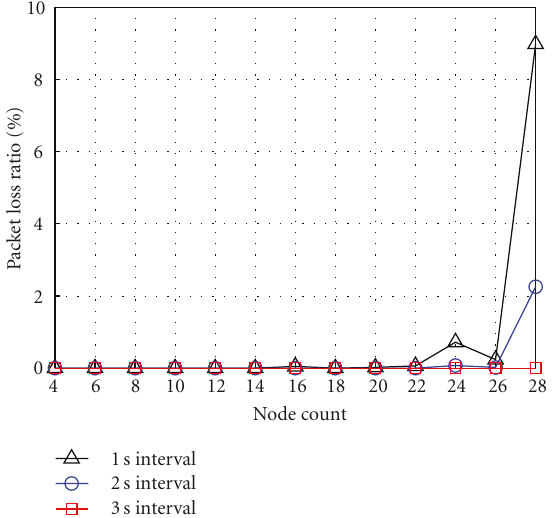
Figure 13: Average packet loss ratio as a function of node amount.